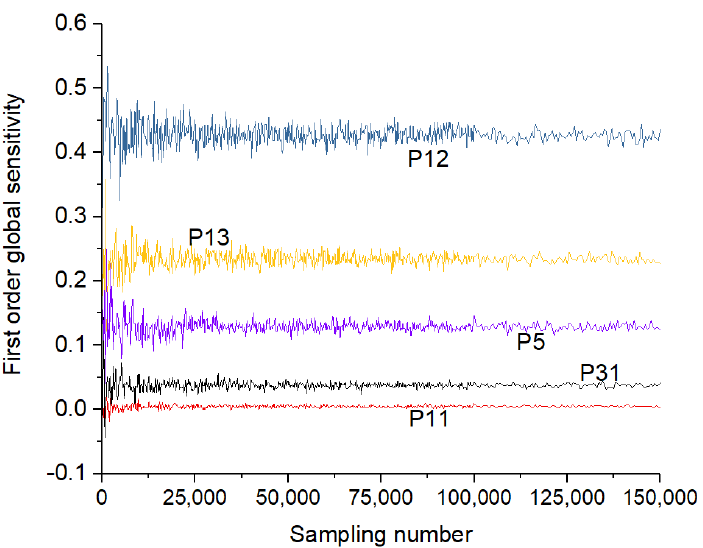
Figure 9. First-order global sensitivity vs. sampling number. Table 4. Sensitivity indices of different design